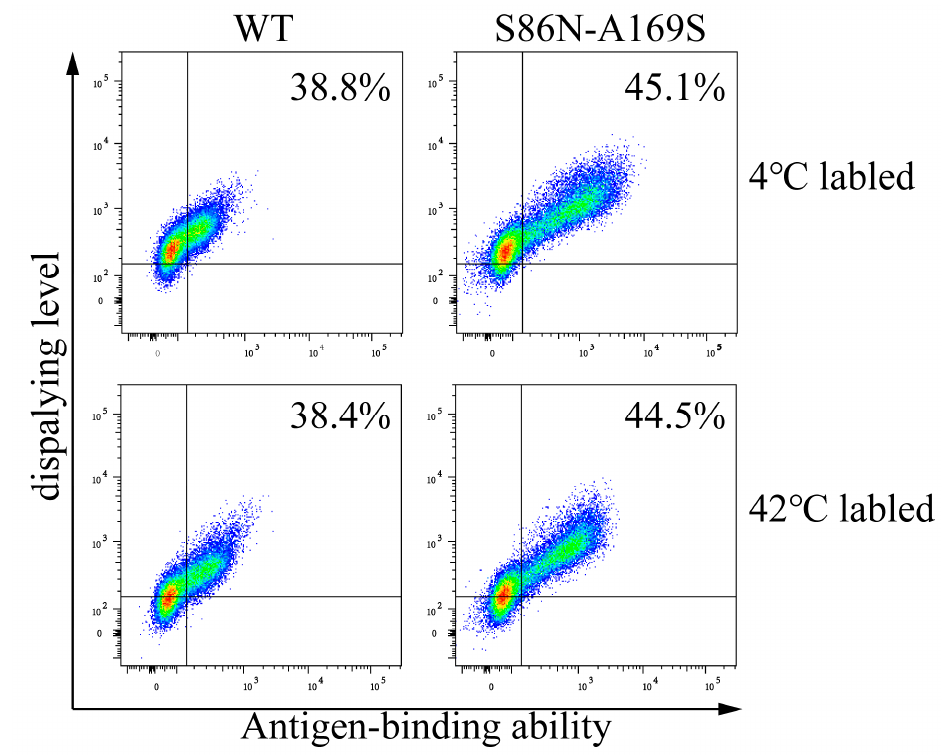
Figure 13. Analyses of the display levels and antigen-binding abilities of wild type (WT) and mutants (S86N-A169S) labeled at 4 and 42 ◦ C. The antibody genes were transiently transfected into cells, respectively, and then were labeled at 4 ◦ C and 42 ◦ C before flow cytometric analysis.